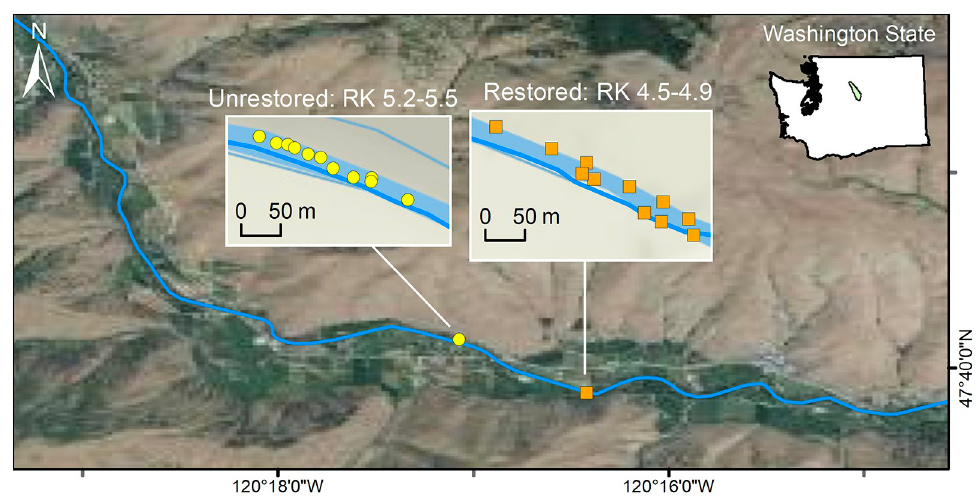
Fig 1. Map of study area in the Entiat River. Locations (river km relative to the confluence with the Columbia River) of the study reaches with restored pools and with unrestored pools are